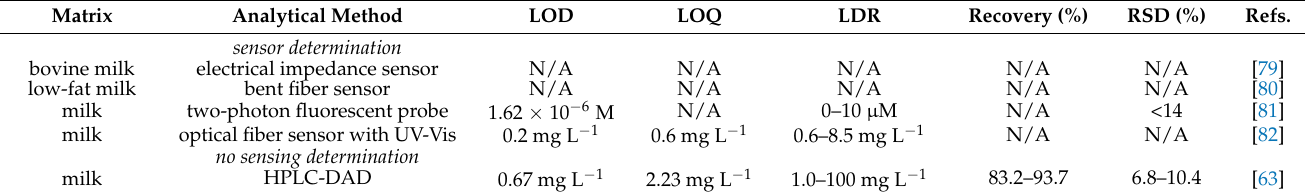
Table 6. Analytical performance of sensing and no-sensing determinations applied to milk and milk-based product matrix. The term “N/A” means the information is absent in the